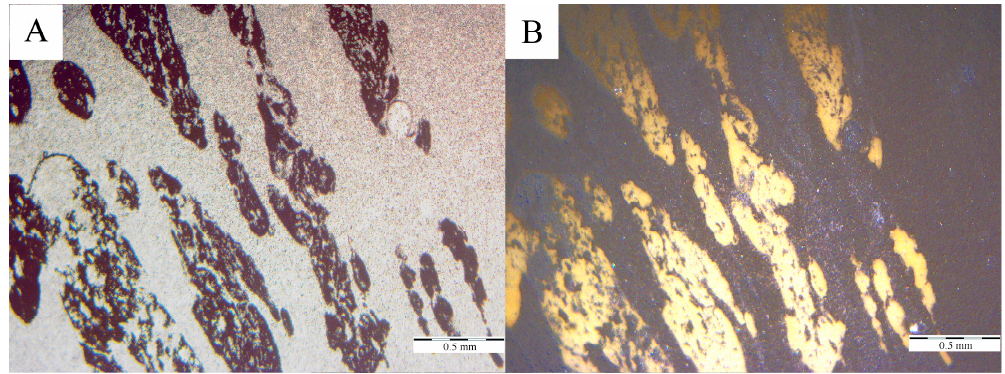
Figure 6. Microphotograph of resin variety III surrounded by variety II, polarized light; 1 N ( A ); NX ( B ).